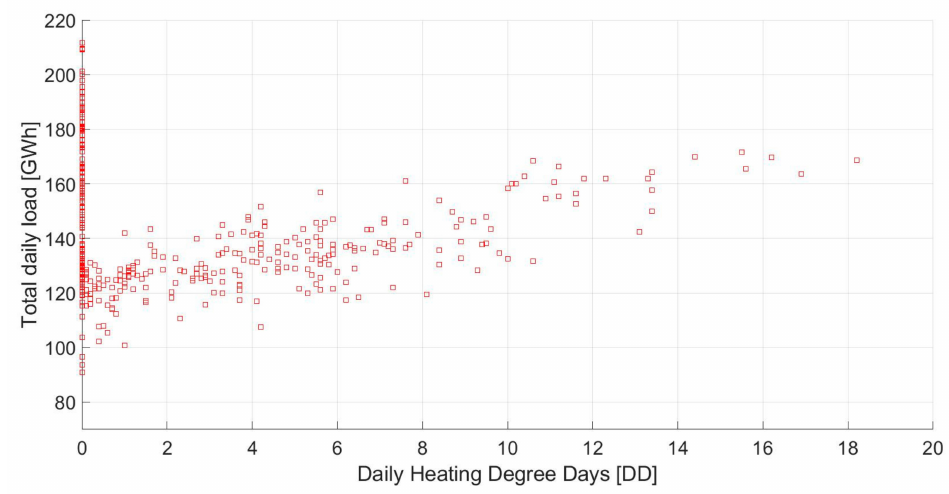
Figure 10. Correlation of the total daily electricity load in GWh with the daily heating degree-days (Psychico station, year 2021).